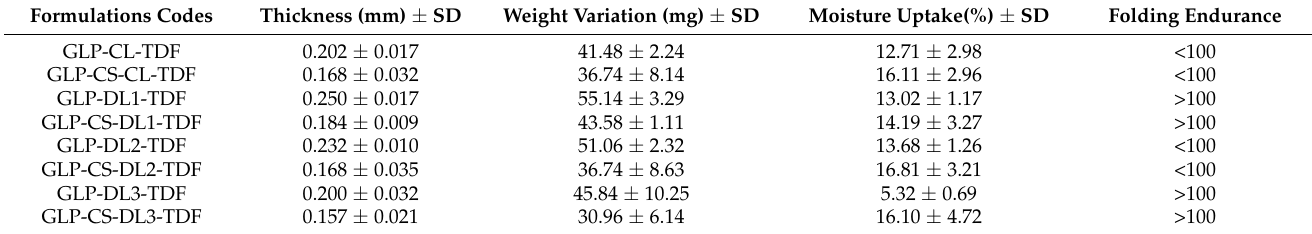
Table 4. Evaluation of GLP-loaded CL-, DL-, and CS-coated liposomes-based transdermal films (TDF).